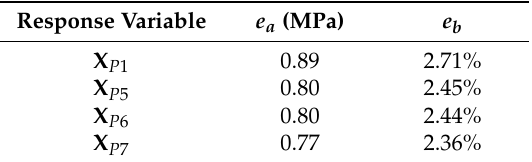
Table 4. The summarized errors using different number of the response variables.